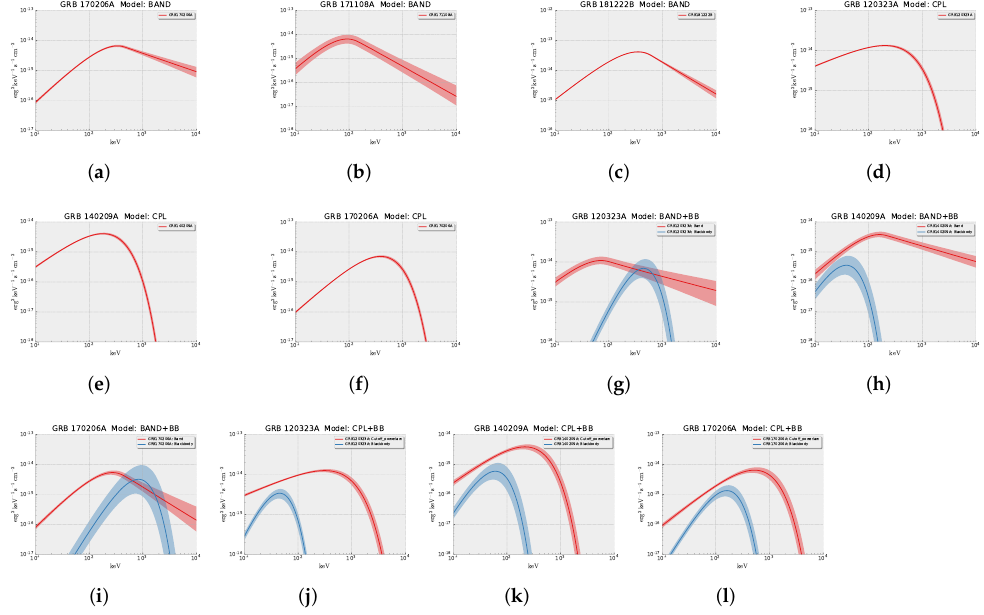
Figure 3. Examples for the SED fitting by four models. ( a ) + ( b ) + ( c ): BAND; ( d ) + ( e ) + ( f ): CPL; ( g ) + ( h ) + ( i ): BAND + BB; ( j ) + ( k ) + ( l ): CPL + BB. In order to compare the multiple spectral components, we select the CPL + BB model to test the correlation between the peak energy E peak = ( 2 + Γ ) E c in the CPL component and the temperature kT in the BB component using the linear fit in logarithmic space same as above. Excluding GRB 150819B, whose median value of kT = 6 keV is less than 8 keV, we found that E peak is strongly correlated with kT with R = 0.97, m = − 1.40 ± 0.31 and n = 1.11 ± 0.12. The best fit for the correlation is written as